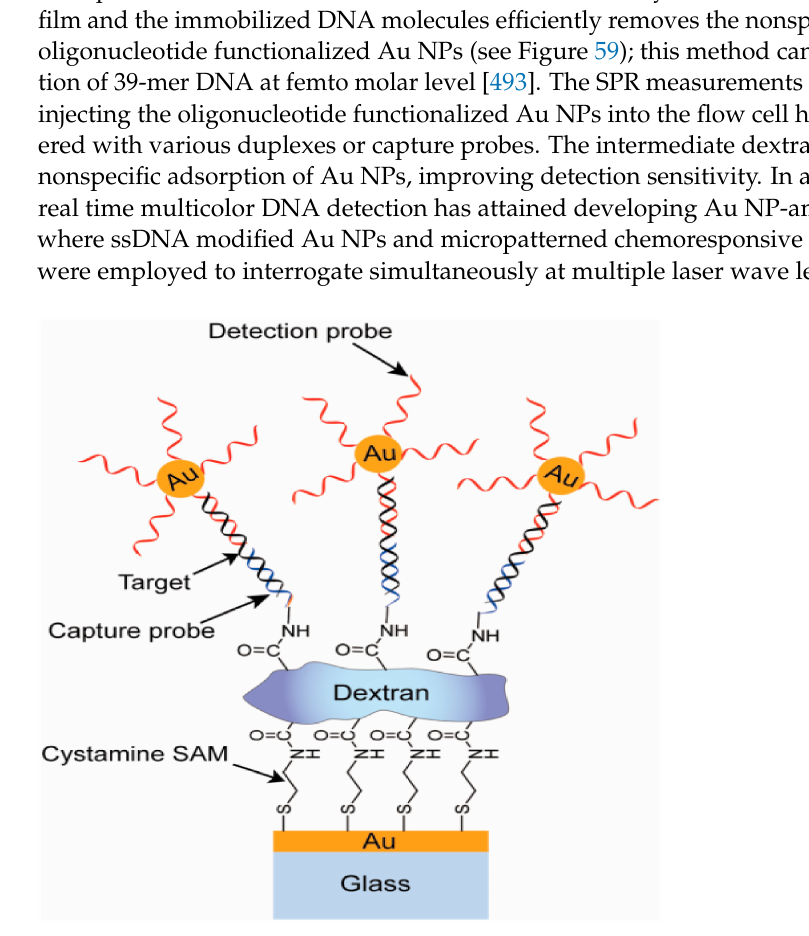
Figure 59. Schematic representation of sandwich DNA detection assay via Au NP mediated SPR signal amplification. Reproduced with permission from Anal. Biochem. [493] Copyright 2006, Elevier